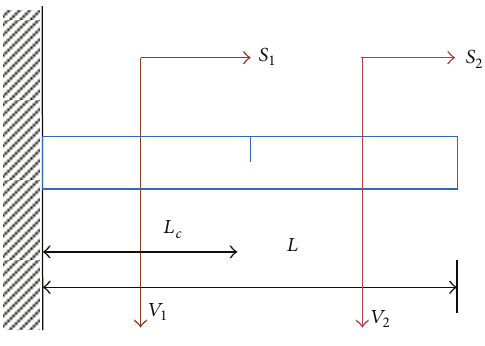
Figure 2: Beam model with